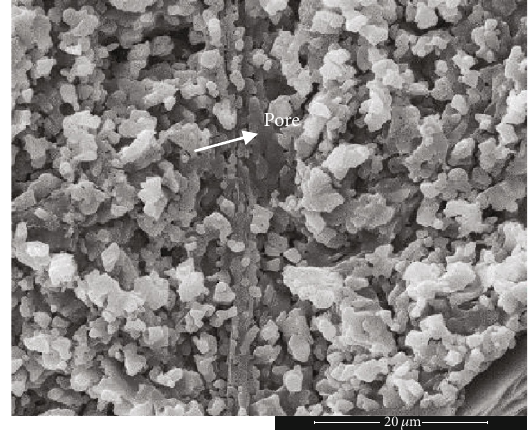
Figure 8: SEM image of natural